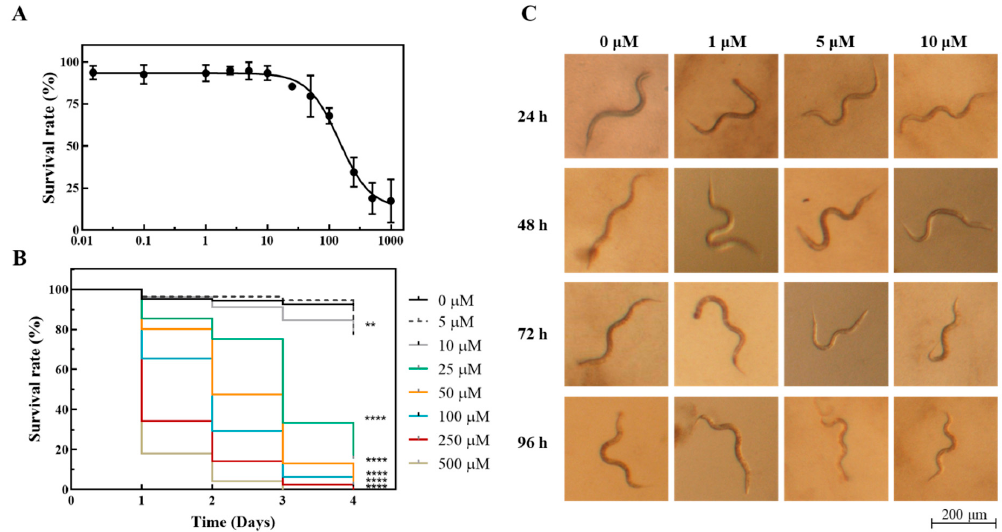
Figure 10. Toxicological evaluation of complex 5 using the C. elegans in vivo model. ( A ) Survival curve of C. elegans L4 larvae upon 24 h exposure to the indicated [Ag(NO 3 )( 1 A) 2 ] concentrations. Error bars represent the standard error of the mean. ( B ) Survival curves of C. elegans treated with single concentrations of the complex and untreated control (no complex, 1% DMSO). Differences compared to the control were considered as significant with ** p < 0.001 and **** p < 0.0001 and were determined using the log-rank (Mantel–Cox) test. ( C ) Representative images of the C. elegans worms after 24 h, 48 h, 72 h, and 96 h exposure to the indicated concentrations of the complex. Scale bars: 200 µ